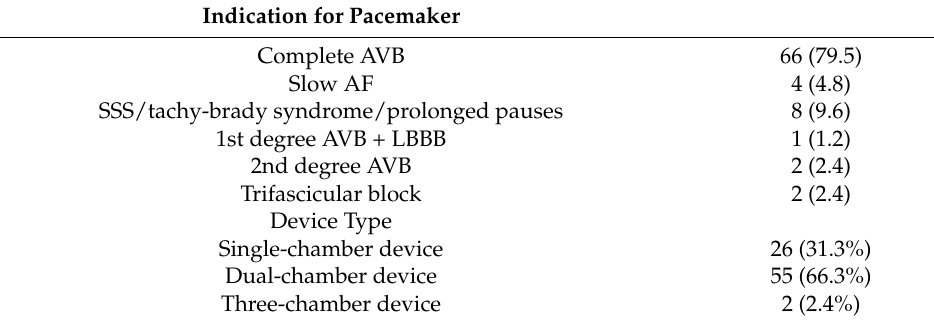
Table 2. Indication for pacemaker implantation and device type.